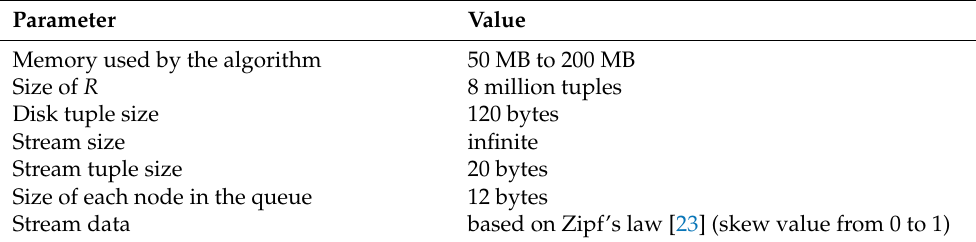
Table 2. Synthetic dataset